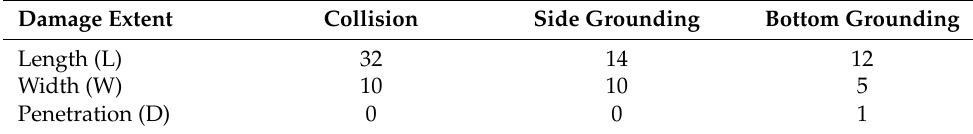
Table 2. Number of accident cases providing quantitative measures of hull breaches.